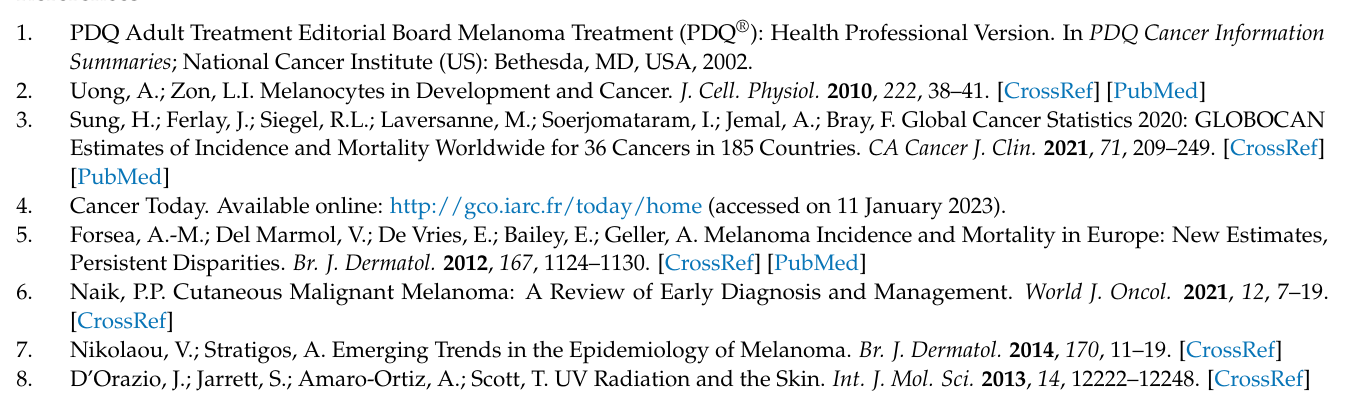
Table S6: List of Differentially Expressed Genes between MES and MEL groups; Table S7: Functional Enrichment Analysis of Differentially Expressed genes between MES and MEL